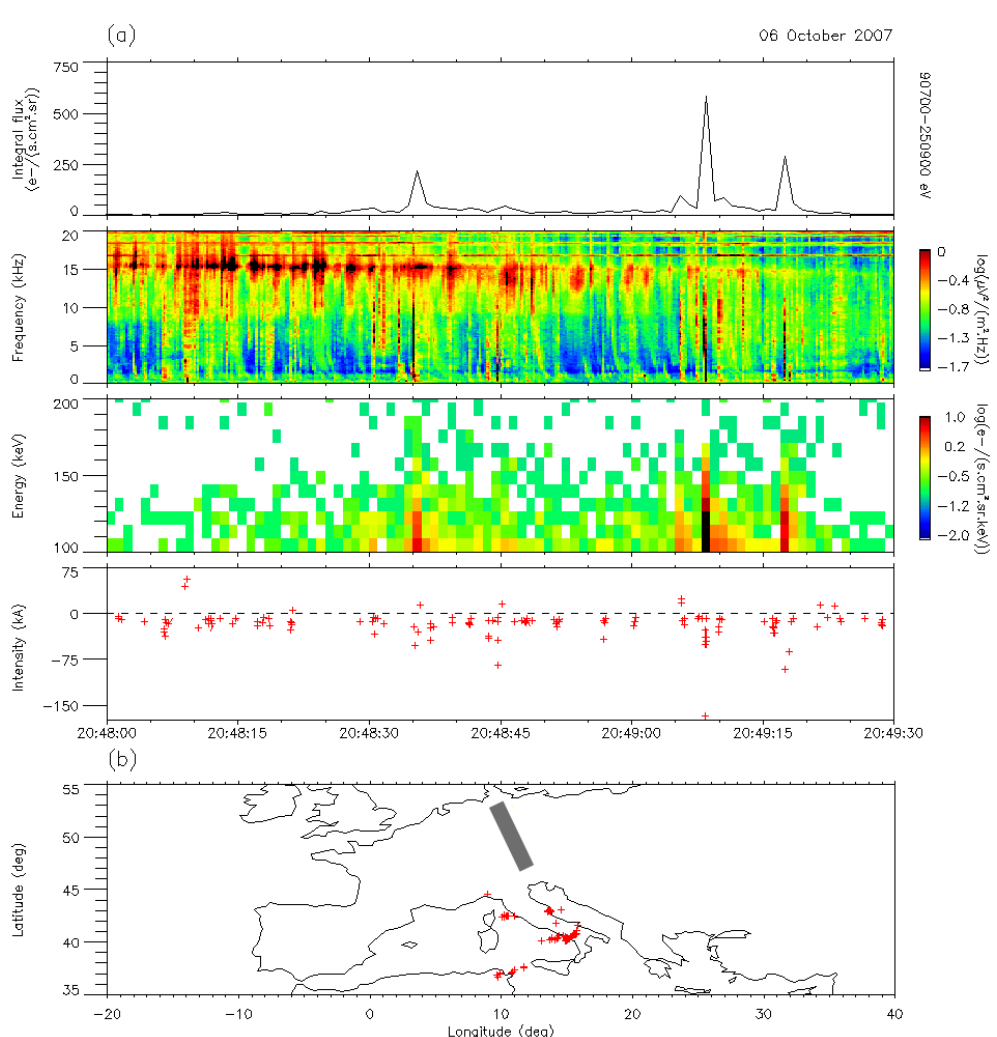
Figure 2. Several LEPs corresponding to an intense storm activity over the Mediterranean region on 6 October 2007. Panel ( a ): from top to bottom: integral electron energy flux from 90 to 250keV; wave-frequency–time spectrogram between 0 and 20kHz; energy–time electron spectrogram from 100 to 200keV; lightning peak currents from Météorage. Panel ( b ): location of intense lightning activity (red crosses) and the trajectory of the spacecraft (grey) when LEPs are